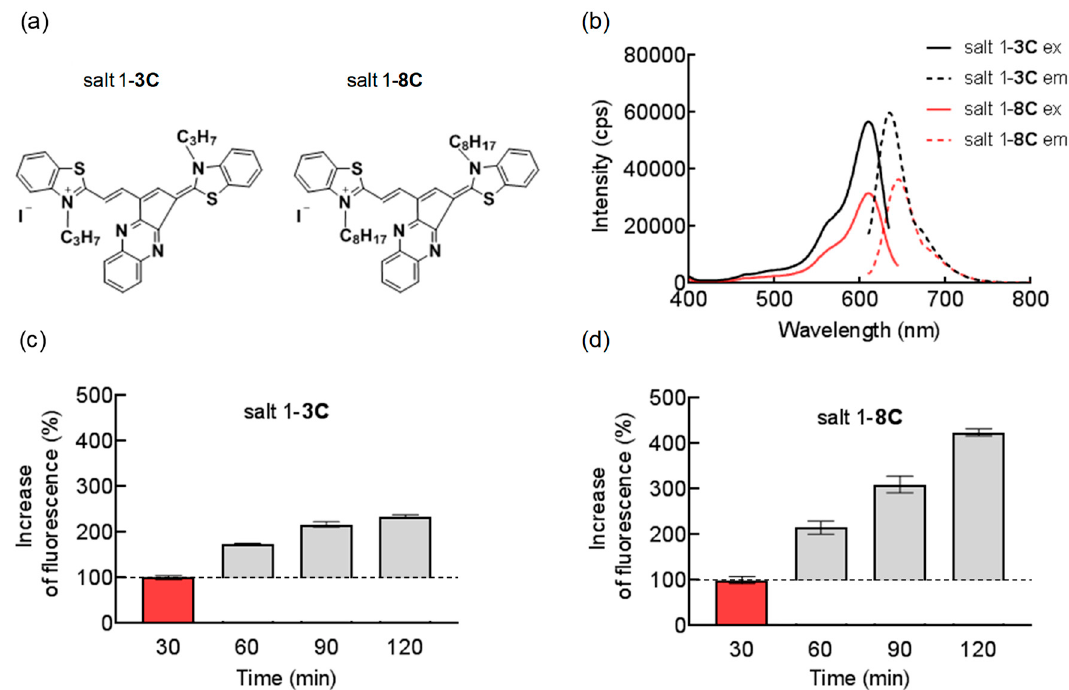
Figure 1. The 1- 8C salt easily permeates cell membranes resulting in higher intracellular concentration. ( a ) Chemical structure of salt 1- 3C and salt 1- 8C . ( b ) Fluorescence spectra of salt 1- 3C and salt 1- 8C measured in DMSO (ex, excitation; em, emission). Uptake of 50 nM ( c ) salt 1- 3C and ( d ) salt 1- 8C measured after 30, 60, 90, and 120 min by flow cytometry. Increase of fluorescence intensity was determined relative to fluorescence measured after 30 min (red column). Emitted fluorescence corresponds to the amount of salts accumulated inside the cells.